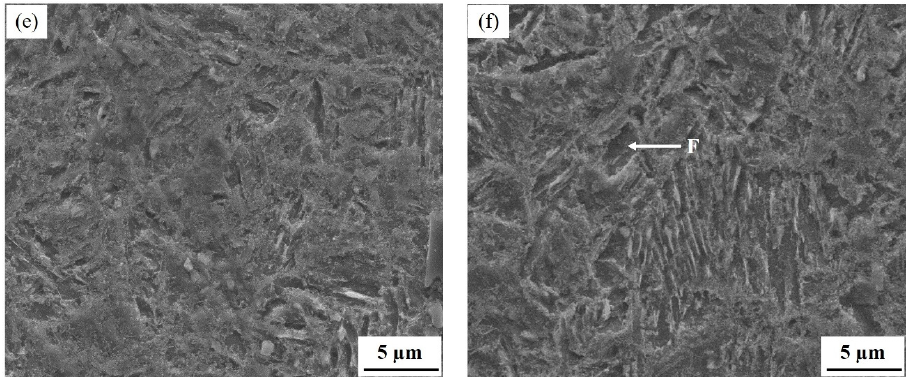
Figure 1. SEM micrographs of specimens of 1.54Si steel ( a , c , e ), and of 1.26Al steel ( b , d , f ): ( a , b ) as- quenched at 210 °C; (c,d) quenched at 210 °C and partitioned-tempered at 450 °C for 60 s; ( e , f ) quenched at 210 °C and partitioned-tempered at 450 °C for 1800 s.